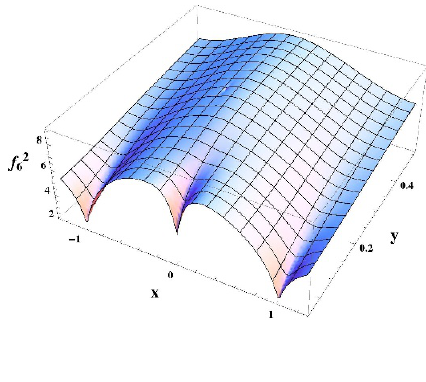
; f 2 and (cid:26) 2 , the real and imaginary parts of the two-form potential 2 6